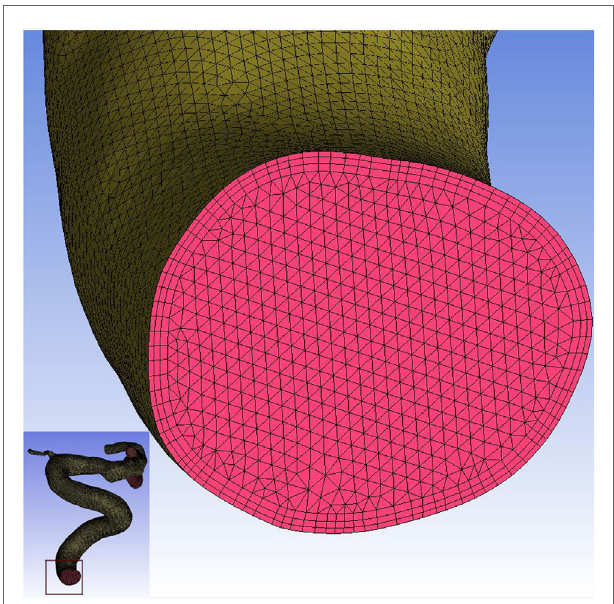
FigUre 1 | Mesh generation in this study . Three layers of prismatic grid were generated near the wall, and the tetrahedron grid was generated in the other